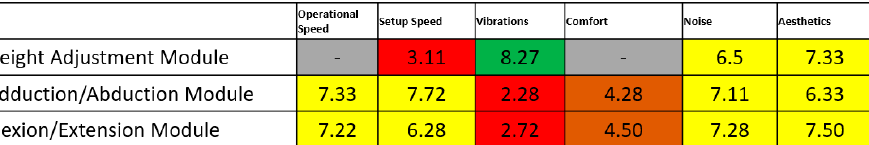
Figure 11. Satisfaction scale. The score obtained by each characteristic is highlighted in Figure 12. The score for Table 2. Height adjustment module. each characteristic was obtained by averaging the values given by each patient. The color code used in Figure 12 is the same from Figure 11. The characteristics highlighted in red definitely need to be improved, and the solutions for their improvements are shown in the Results section.